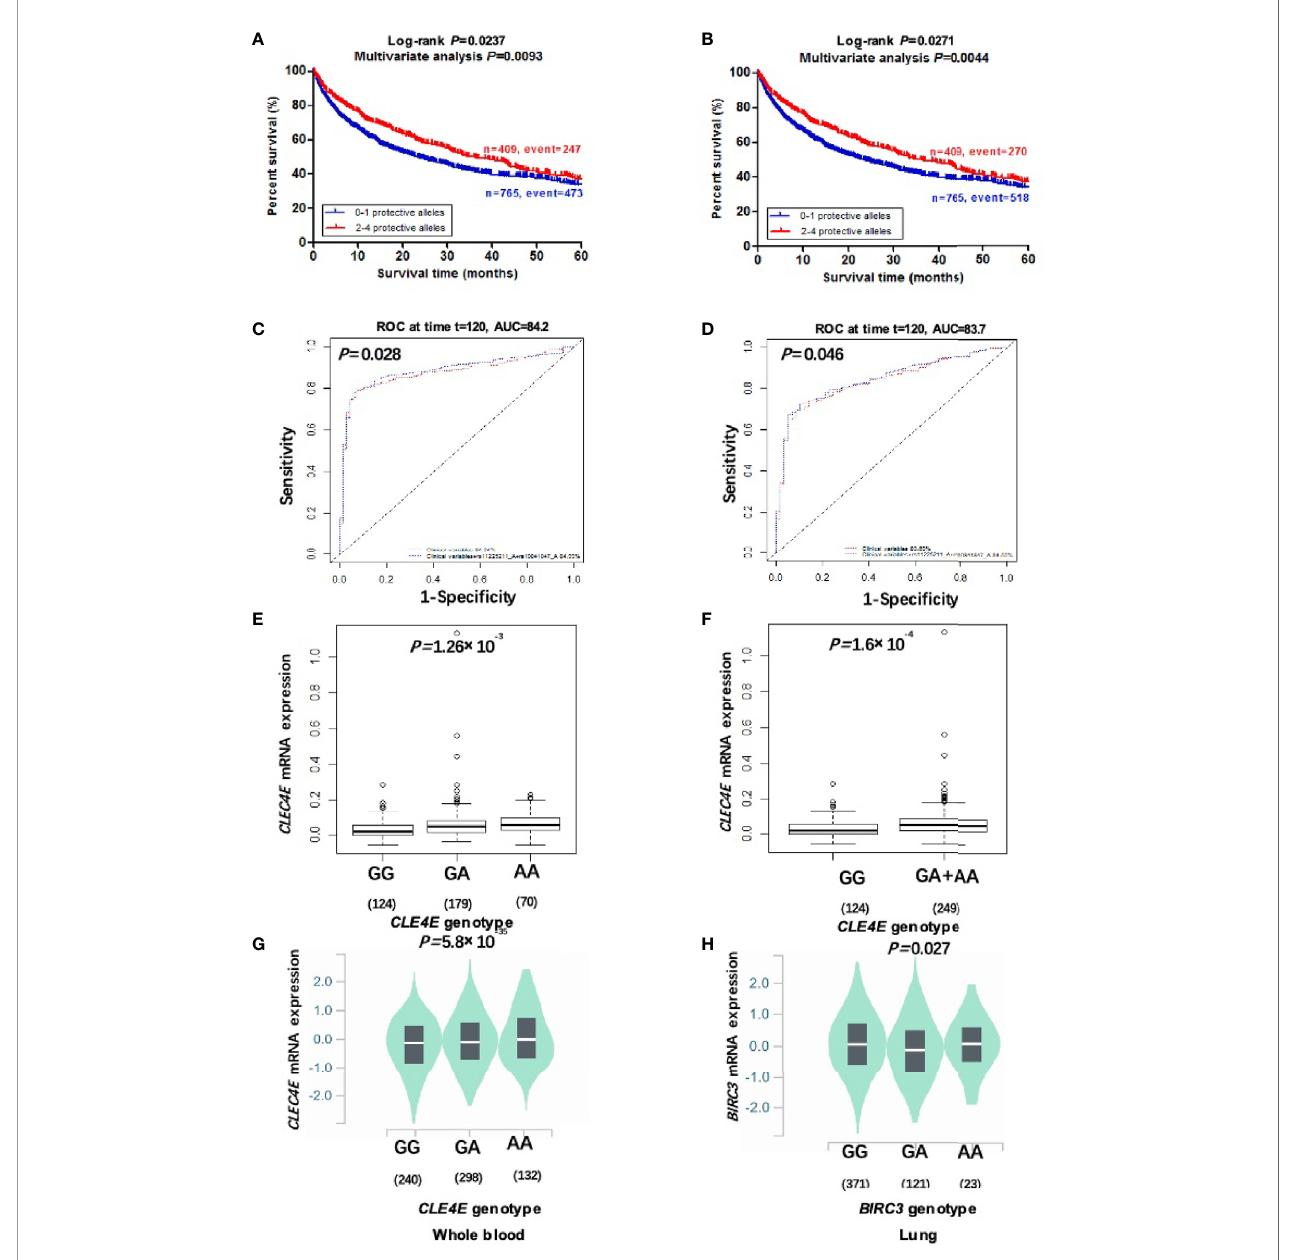
FIGURE 2 | Two independent SNPs in DAMP-related pathway genes predict NSCLC patient ’ s survival and eQTL analysis. Kaplan-Meier survival curves of the combined risk alleles (0-1 vs . 2-4) of CLEC4E rs10841847 G>A and BIRC3 rs11225211 G>Ain the PLCO trial for DSS (A) and OS (B) . The ten-year NSCLS DSS prediction by ROC curve based on clinical variables plus protective alleles (C) . The ten-year NSCLS OS prediction by ROC curve based on clinical variables plus protective alleles (D) . The correlation of rs10841847 genotypes and CLEC4E mRNA expression in additive (E) and dominant model (F) from the 1000 Genomes Project. The correlation of rs10841847 and CLEC4E mRNA expression in whole blood samples from the GTEx (G) . The correlation of rs11225211 and BIRC3 mRNA expression levels in normal lung tissues from the GTEx (H) . PLCO, The Prostate, Lung, Colorectal and Ovarian Cancer Screening Trial; DSS, disease-speci fi c survival; OS, overall survival; NSCLC, non-small cell lung cancer; ROC, receiver operating characteristic; GTEx, Genotype-Tissue Expression